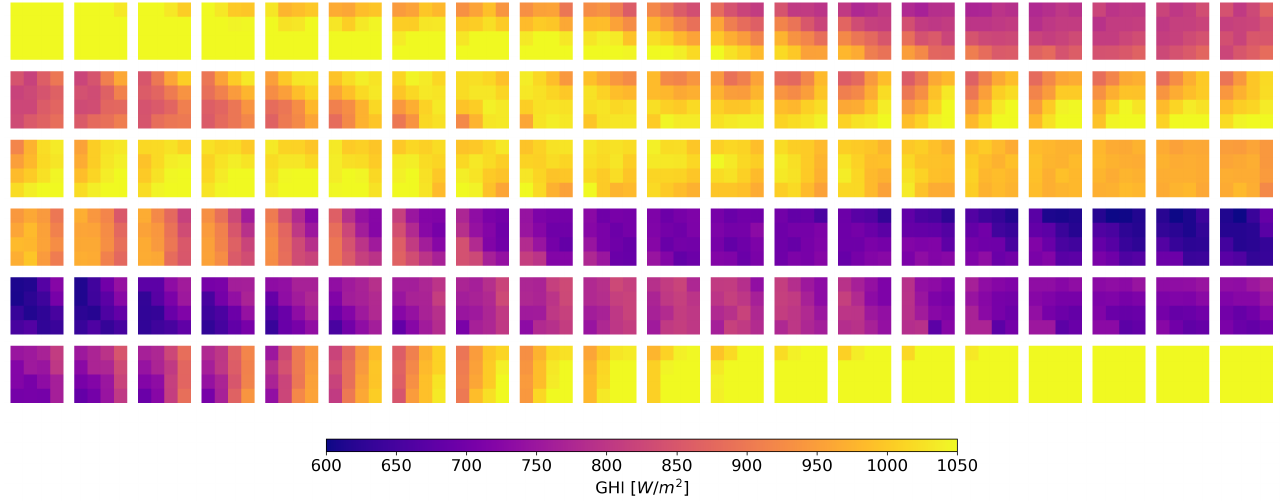
Figure 15. 60 s of snapshots evolution at 500 ms from time series shown in Figure 14 acquired with the designed WSN. Each row represents 10 seconds of the